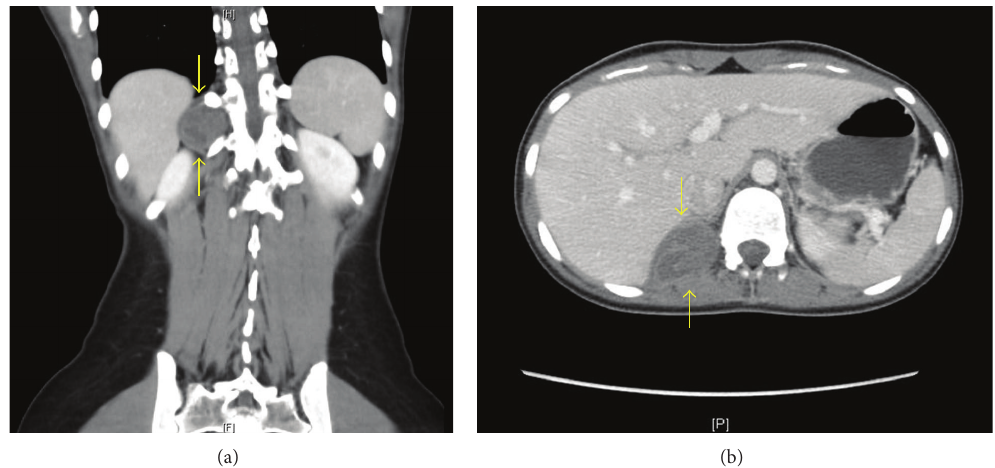
Figure 1: Coronal (a) and transverse (b) contrast-enhanced computed tomography (CT) scans showing a 4.2 × 3.2 cm, heterogeneous noncalcified mass involving most probably the right adrenal gland region